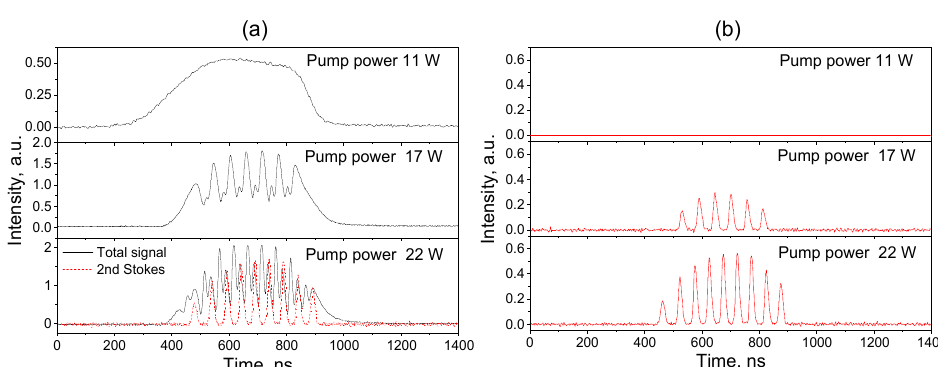
Figure 3. Output average power of RFL as a function of coupled to fiber input pump power ( a ) and output spectrum at different LD pump powers in 62.5- μ m GRIN fiber Raman laser with the open- space AOM ( b ).